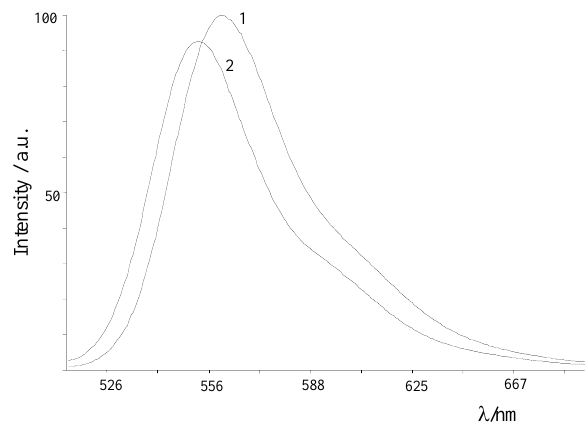
Figure 6. Emission spectra of DODR in aqueous CTAB solutions (0.01 M): HR + , pH = 0–0.5, (1) and ± , pH = 9.2 R